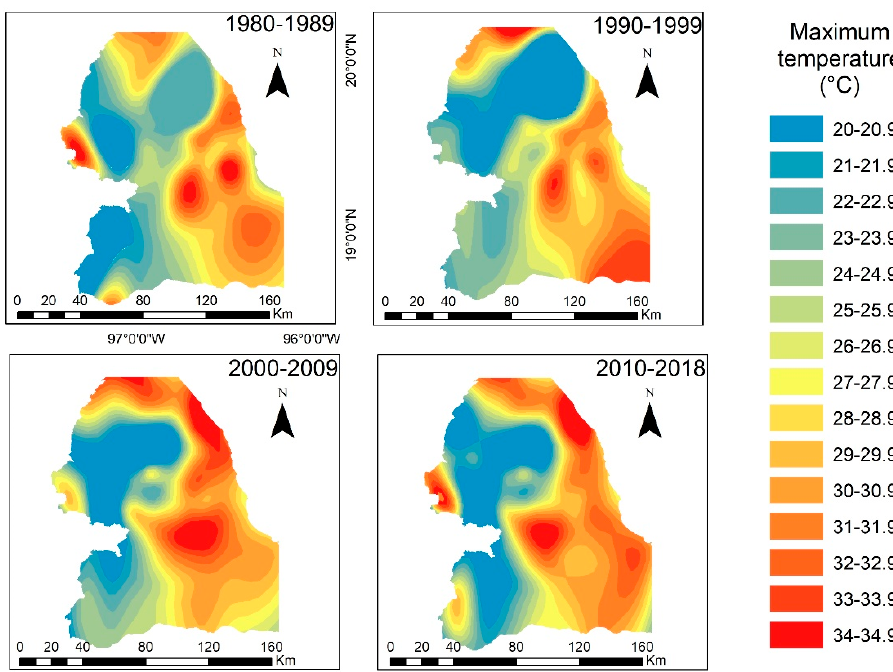
Figure 3. Analysis of the maximum temperature behavior (°C) during the months March to Septem- ber per decade in the study area — 1980s, 1990s, 2000s, and 2010 – 2018